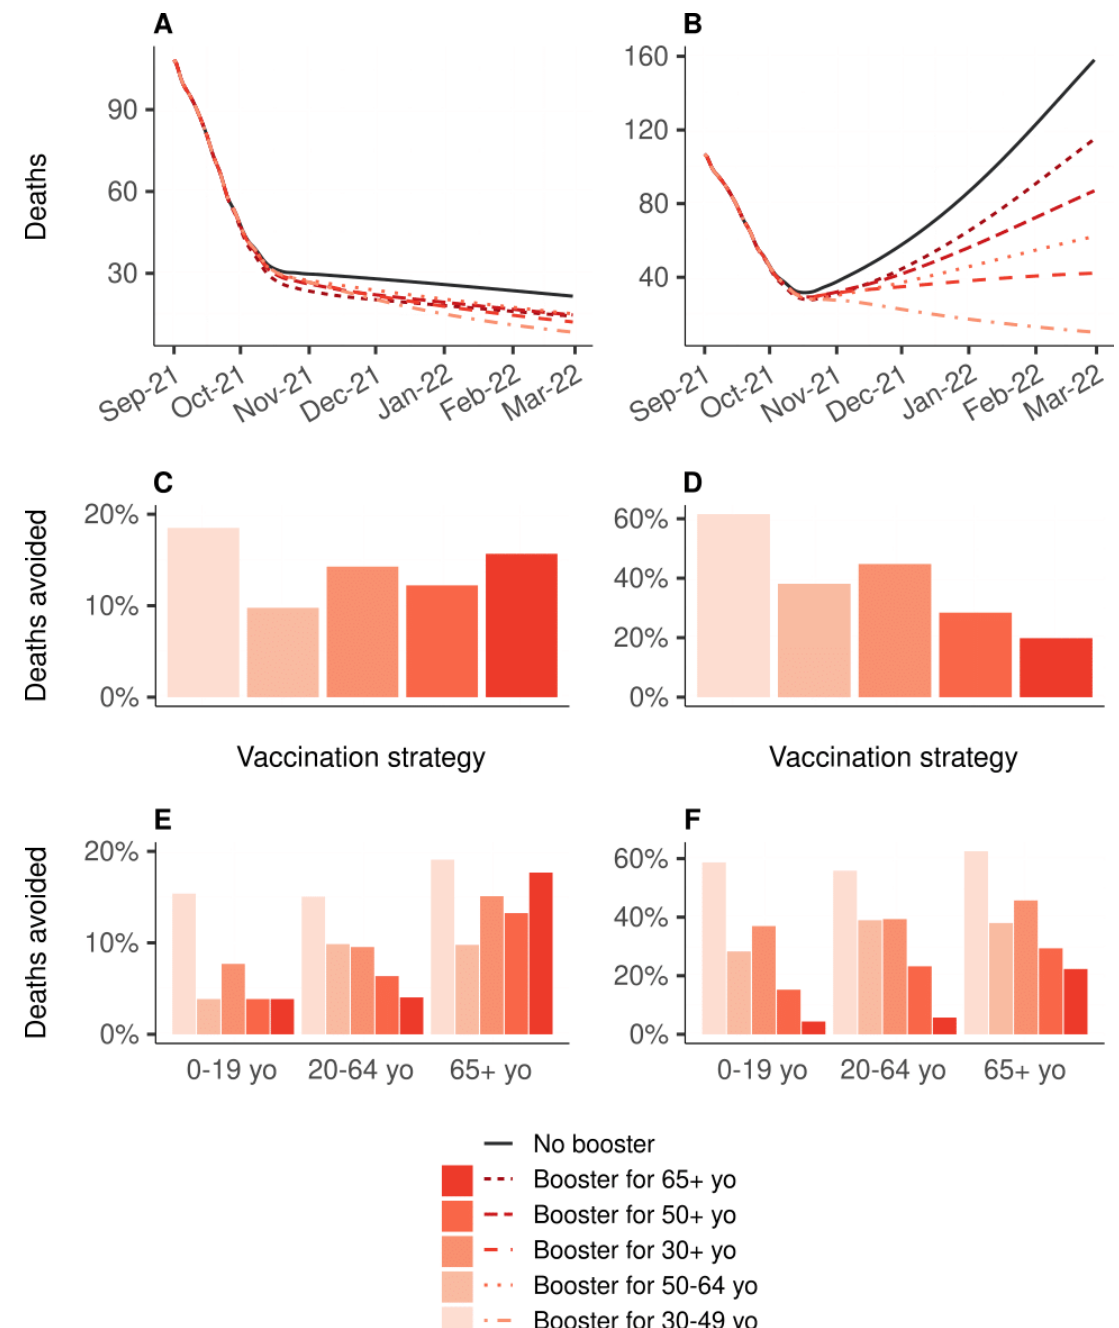
Figure 3. Impact on the number of deaths of 10 million booster shots depending on the targeted age groups, over the period from 1 September 2021 to 1 March 2022, compared to a baseline scenario of no booster shots. In all strategies, primary vaccination is stopped on 1 September 2021. ( A , C and E ) Vaccine efficacy decreased only for people aged 65 years and older. ( B , D and F ) Vaccine efficacy decreased for all age groups. ( A , B ) Daily deaths, ( C , D ) proportion of deaths avoided, (E, F) proportion of deaths avoided by age group. Note that only the booster strategy targeting the 30 – 49 yo had an impact on the percentage of deaths avoided in the 0 to 19 yo on inset E (one death avoided).